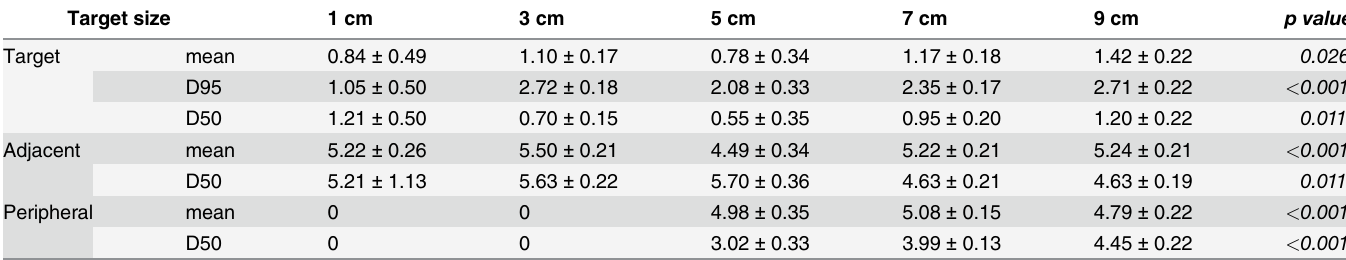
Table 6. Dose deviation (%) with various dose parameters between the 3DVH-predicted and planned doses with respect to target size. Target